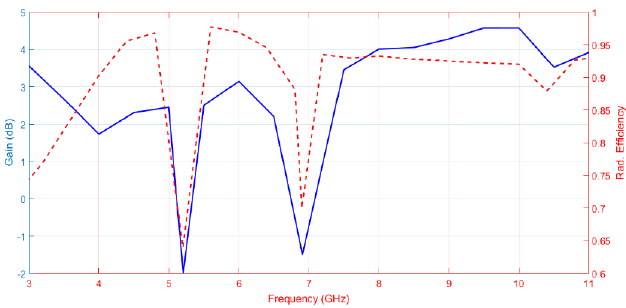
Figure 11: The gain and radiation efficiency versus frequency for the antenna with two HSRRs ESRR4 and ESRR2 with